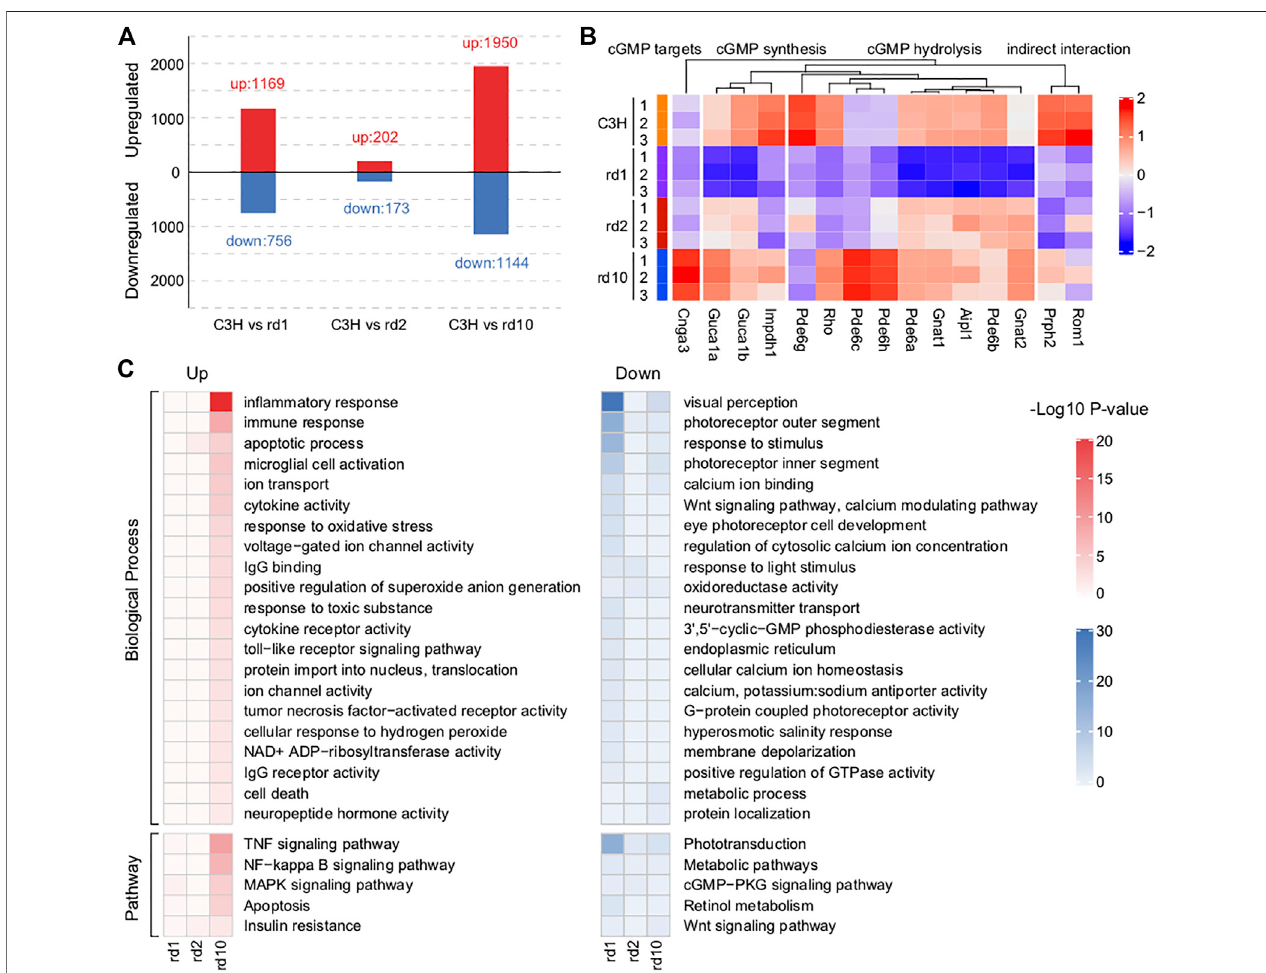
FIGURE3| Impaired functionsrelated tophototransductionfoundinRDmice retina. (A) Thenumbers ofdifferentiallyexpressed genes(DEGs)betweenC3Hmice and each RD model. A total of 1925 DEGs (1,169 up-regulated and 756 down-regulated), 375 DEGs (202 up-regulated and 173 down-regulated), and 3,094 DEGs (1950 up-regulatedand 1,144 down-regulated)were respectively identi fi ed between Pde6b rd1 and C3H mice, between Prph rd2 and C3H mice,and between Pde6b rd10 and C3H mice. (B) Changesintheexpression ofkeygenesrelated tocGMPsynthesis, hydrolysis, and targets inRD miceversusthatinC3H mice.Genesinvolved in cGMP synthesis and hydrolysis were generally differentially expressed, especially in the PDE6 mutant Pde6b rd1 and Pde6b rd10 mice. (C) Functional enrichment analysis of the identi fi ed DEGs based on p < 0.05. These up-regulated DEGs mainly were enriched ion channel activity, in fl ammatory process, immune response, TNF signaling pathway, MAPKsignaling pathway, and microglial cellactivation. The down-regulatedDEGs were related tovisual perception, Wntsignaling pathway, calcium modulating pathway, positive regulation of GTPase activity, cGMP-PKG signaling pathway and retinal metabolism.